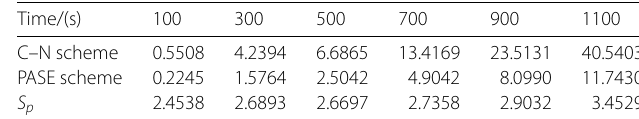
Table 4 The computing time and speedup ratio of C–N scheme and PASE-I scheme Time/(s) 100 300